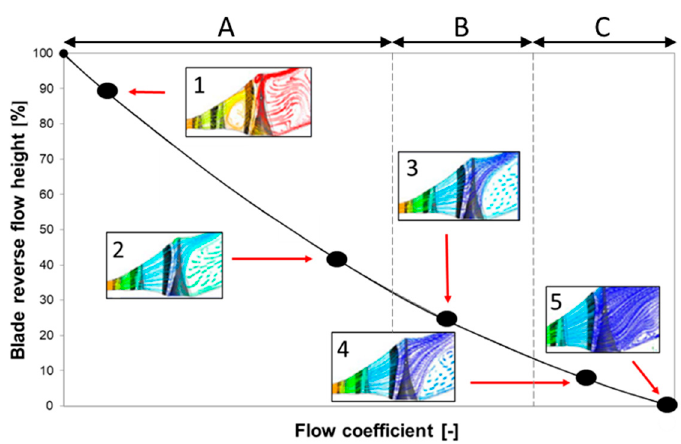
Figure 6. Schematic representation of the variation in blade reverse-flow height for different flow coefficients. Subfigures 1-5 show the flow field for the different test cases [16].